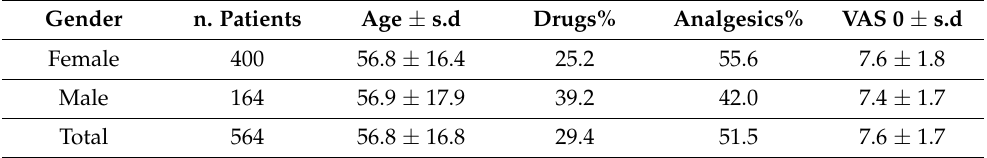
Table 1. Sex, average age, percentage of patients taking medication and analgesics and VAS score at time 0. Gender n. Patients Age ± s.d